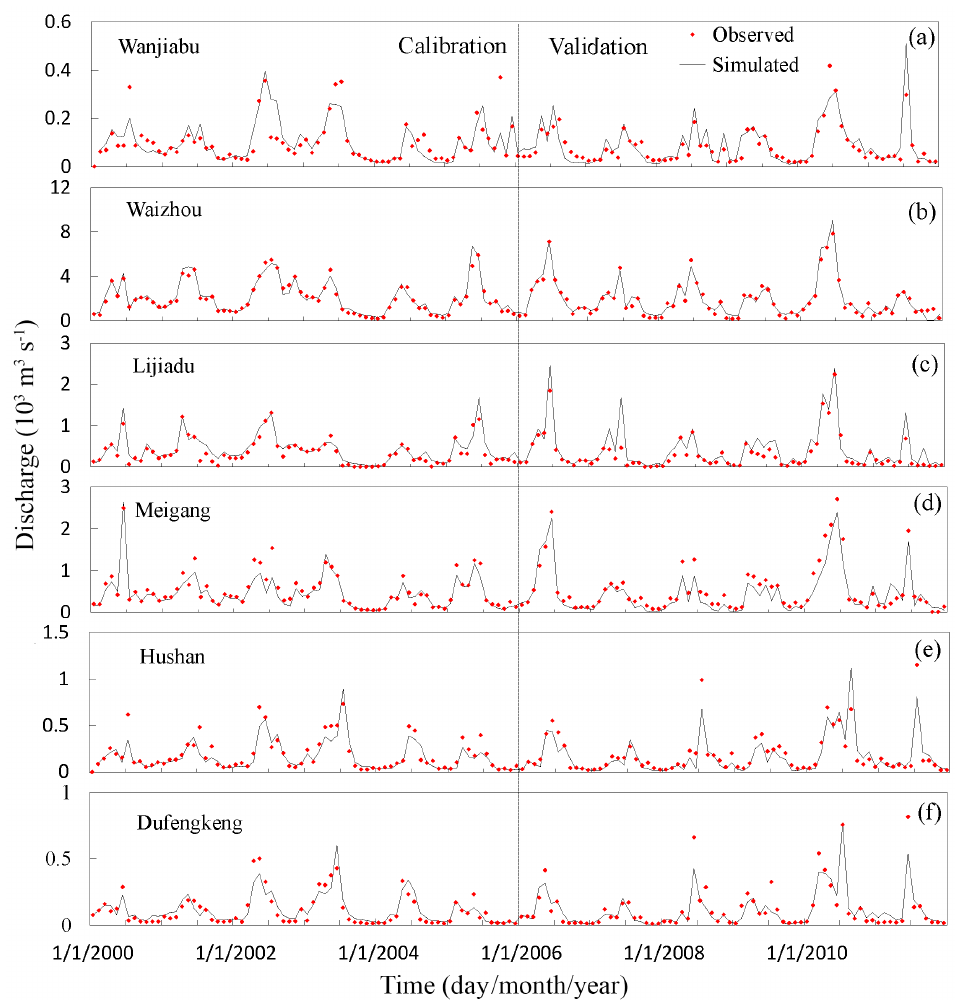
Figure 4. Comparison of observations and the results simulated from the SWAT model for calibration (2000–2005) and validation (2006– 2011). Panels (a) , (b) , (c) , (d) , (e) , and (f) are the calibration and validation results for stations at Wanjiabu, Waizhou, Lijiadu, Meigang, Hushan, and Dufengkeng,